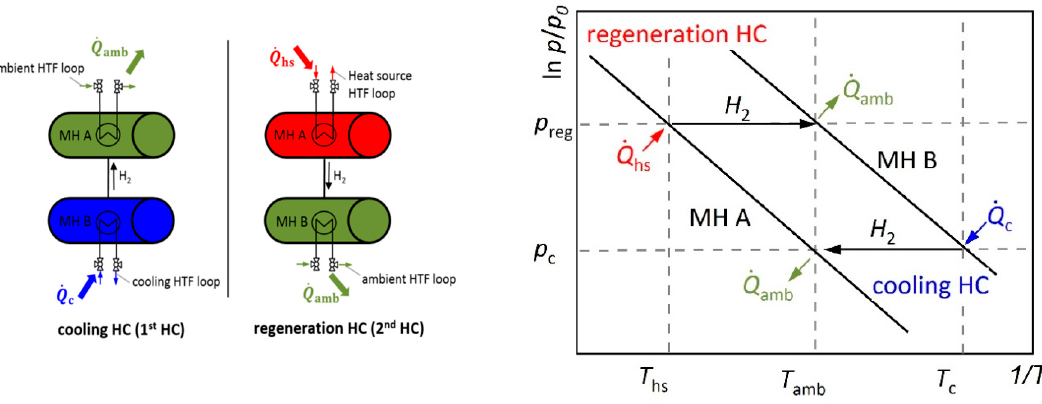
Figure 1. Schematic illustration (left) and van’t Hoff plot (right) of thermally driven closed metal hydride cooling systems (MHCSs).